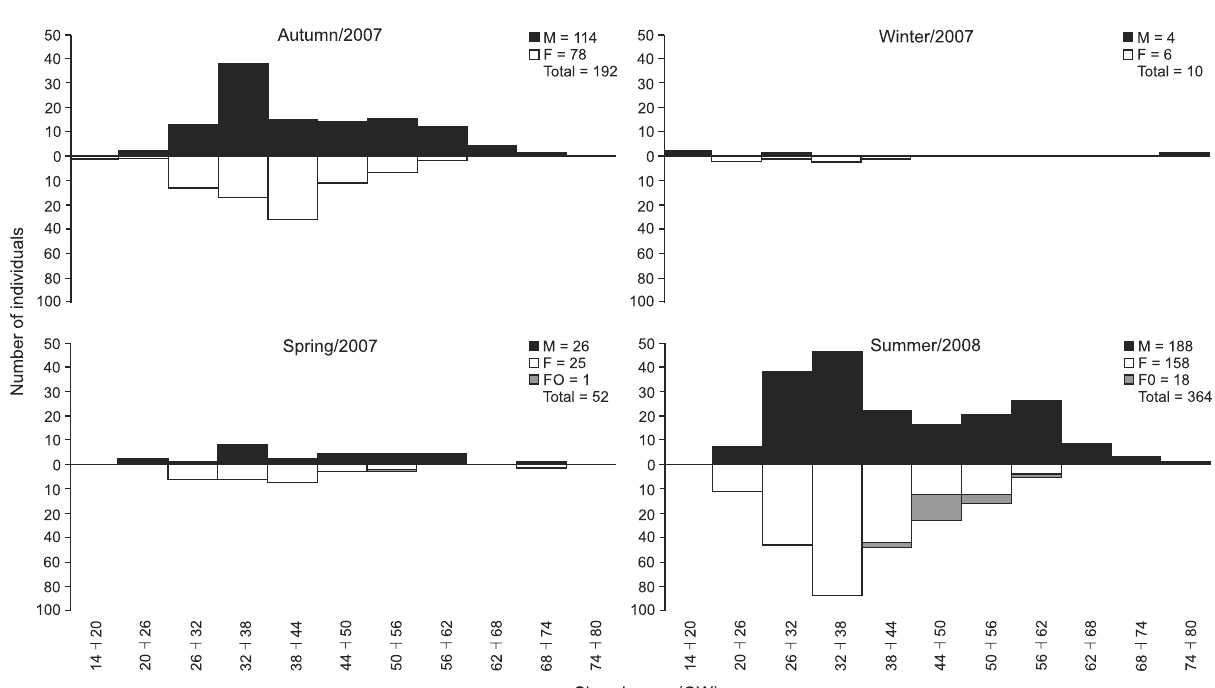
Figure 5. Size-frequency distribution of Callinectes ornatus caught monthly in the Estuary-Bay Complex of São Vicente (juveniles in- cluded), by season (Autumn: March-May, Winter: June-August, Spring: September-November, Summer: December-February). (OF) Ovigerous females, (F) females, (M) males. Measurements in millimeters.